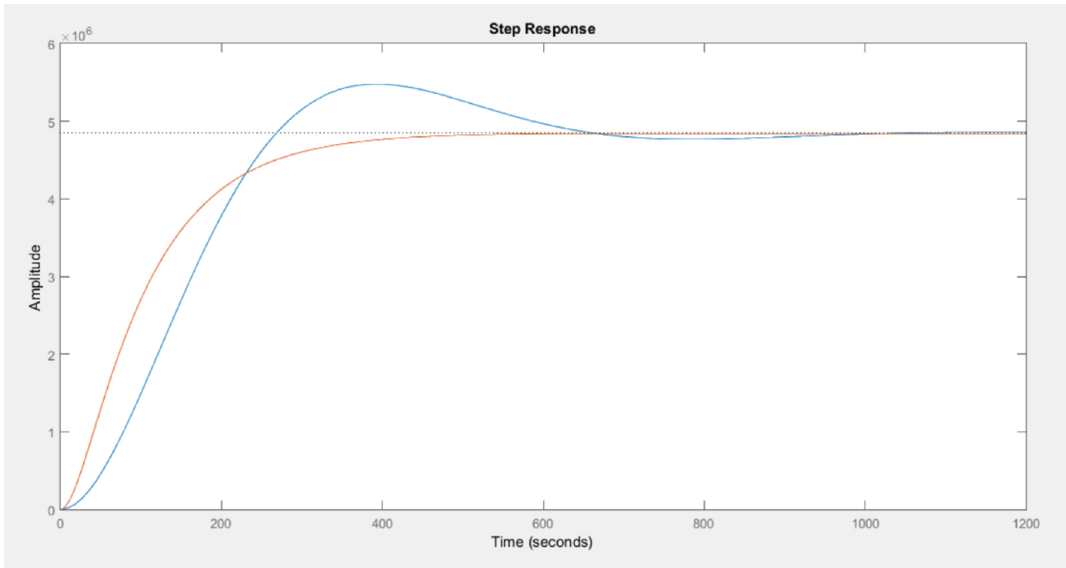
Figure 7. Length = 50 km, diameter = 1 m, mass flow = 120 kg/s.